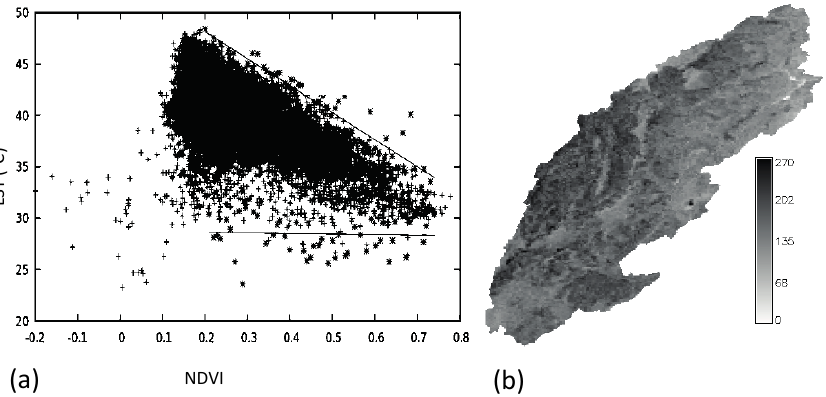
Fig. 3 Assessment of AET: (a) LST–NDVI space for SRB on 5 June 2001; and (b) map of monthly AET (mm) for Fuensanta basin on July